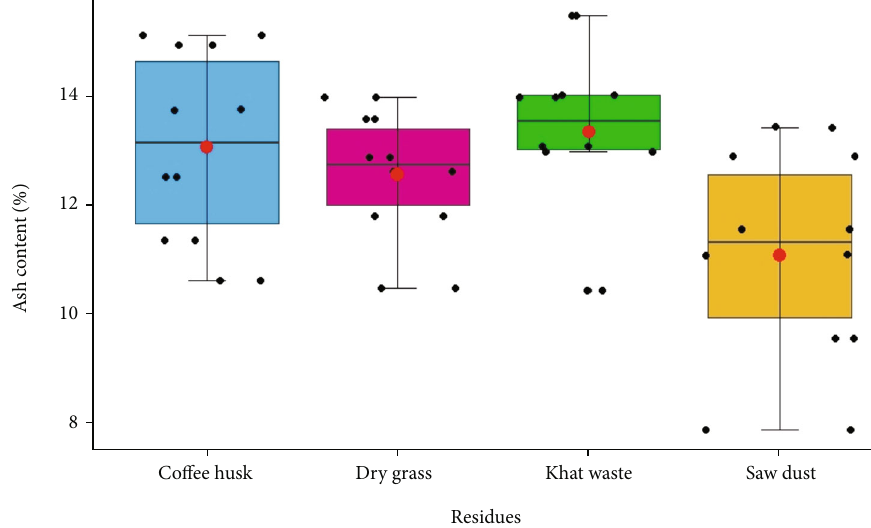
Figure 4: Response of ash content percentage to produced briquettes from di ff erent residues.